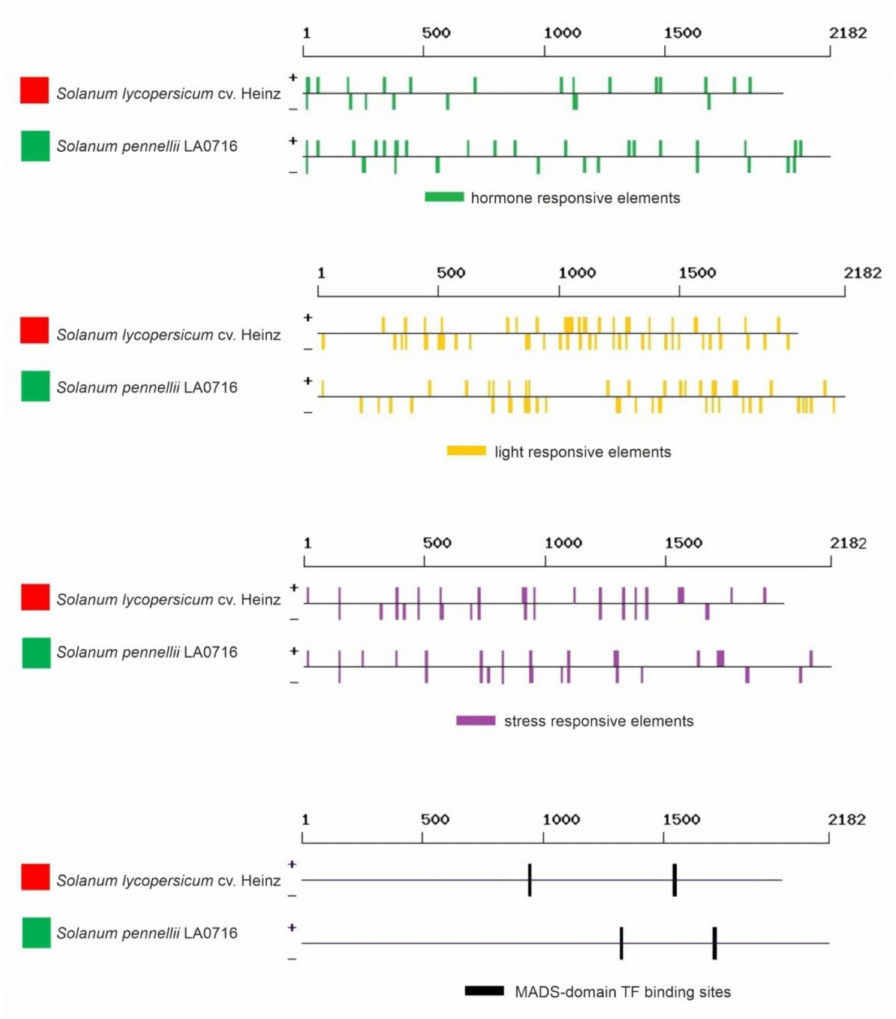
Figure 6. Regulatory elements identified in silico in the promoter sequences of S. lycopersicum cv. Heinz 1706 (FSCV) and S. pennellii LA0716 Z-ISO genes. Red and green squares correspond to the color of the fruit of the analyzed tomato accessions. The localization of the elements is rendered according to the data in Supplementary Table